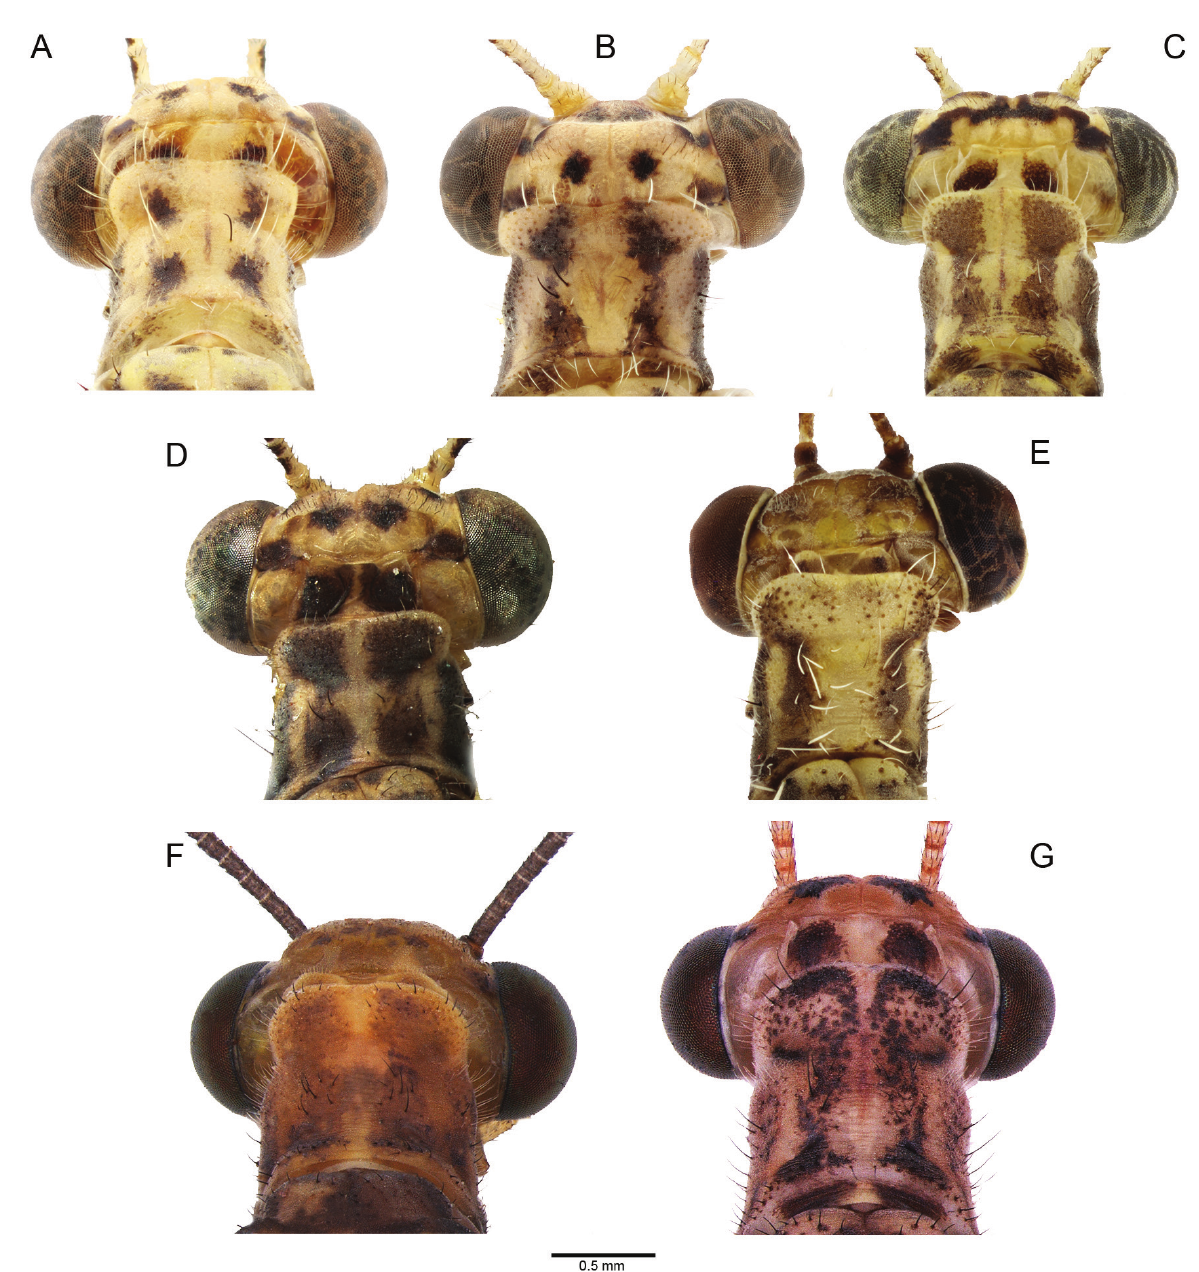
Figure 2. Head and pronotum of Gymnocnemia and Megistopus , dorsal view. A–C Gymnocnemia variegata , variability, A Italy, Lazio, Rome [type locality], B Slovenia, C Italy, Sardinia; D Gymnocnemia editaerevayae , holotype [Morocco, High Atlas] (Photo: B. Michel, CBGP); E Gymnocnemia mirabilis [Oman, Jabal Shams]; F Megistopus flavicornis [France, Gard]; G Megistopus lucasi [Italy,